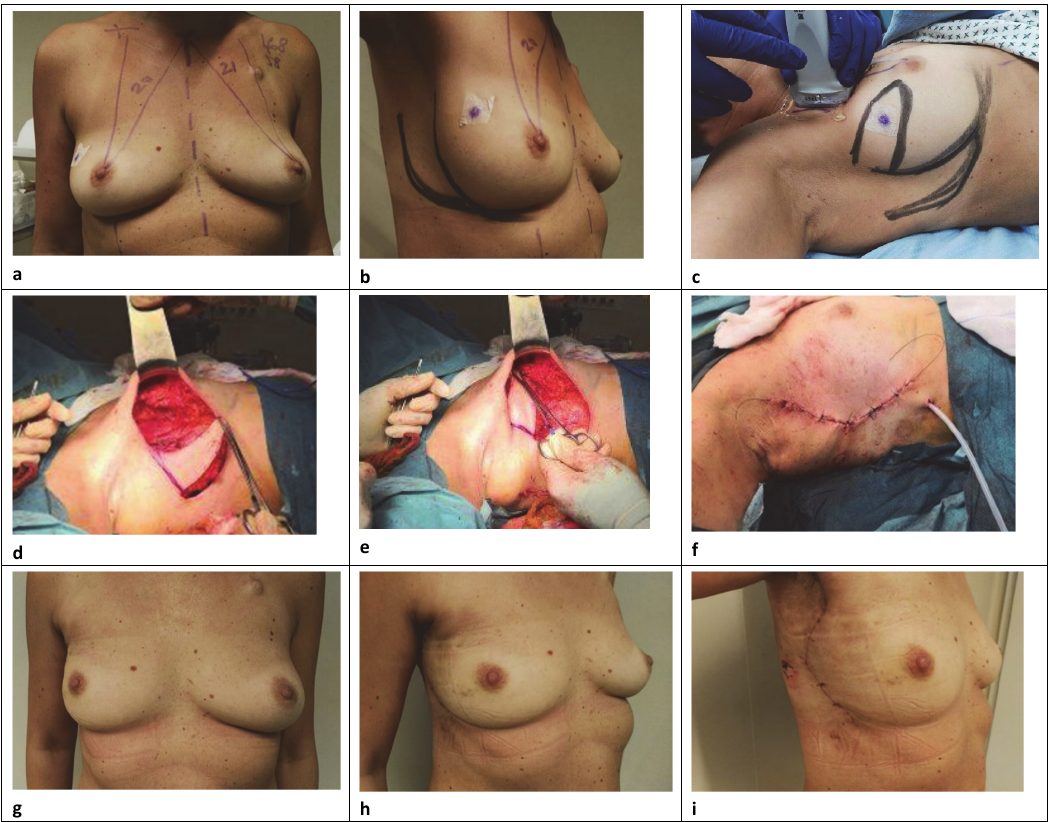
Figure 2. A 45-year-old woman with right invasive ductal carcinoma (yT0N0, Triple Negative G3). ( a , b , c ) Preoperative markings are shown. ( c , d , e ) Segment resection of the upper outer part on the right using the subaxillary replacement flap technique after neoadiuvant chemotherapy. ( e,f ) On table results after closing defect. ( g , h,i ) One month after surgery, frontal and side view.